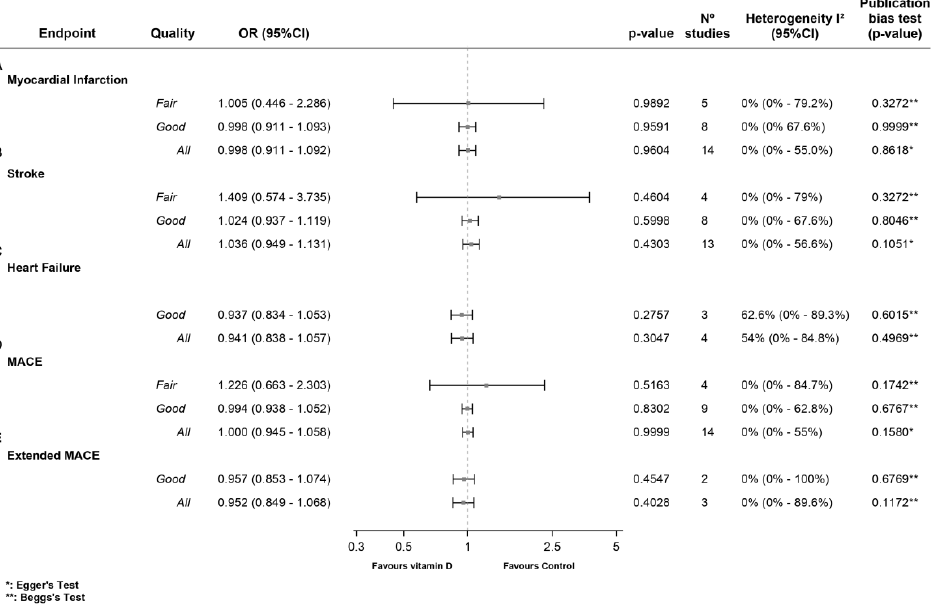
Figure 4. Forest plots of the effect of vitamin D supplementation on cardiovascular outcomes. ( A ) Effect of vitamin D supplementation on nonfatal myocardial infarction. ( B ) Effect of vitamin D supplementation on nonfatal stroke (haemorrhagic or ischemic). ( C ) Effect of vitamin D supplementation on heart failure. ( D ) Effect of vitamin D supplementation on the composite endpoint of major adverse cardiovascular events (MACE), including cardiovascular mortality, along with fatal and nonfatal myocardial infarction. ( E ) Effect of vitamin D supplementation on extended MACE, com- posite endpoint including MACE or coronary revascularization procedures (percutaneous coronary intervention or coronary artery bypass